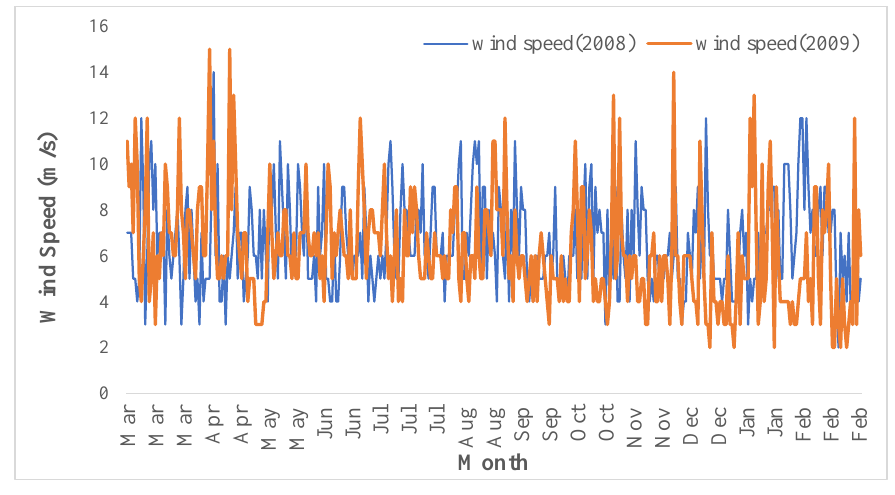
Figure 3. Time series of sea surface temperature, air temperature and horizontal vision in 2009 (sst: Sea surface temperature, temp: Air temperature).